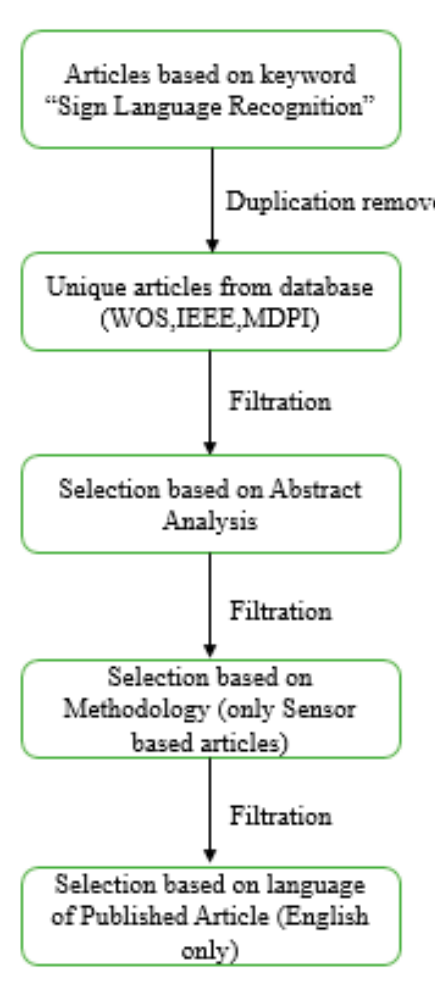
Figure 13. Article filtration procedure for literature review.